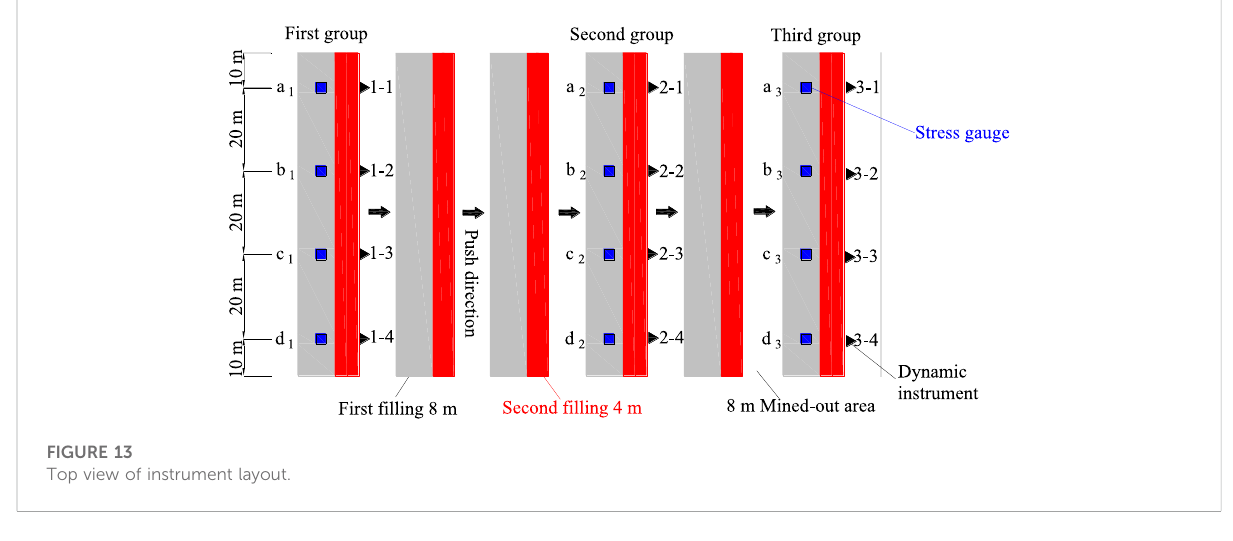
FIGURE 13 Top view of instrument layout.